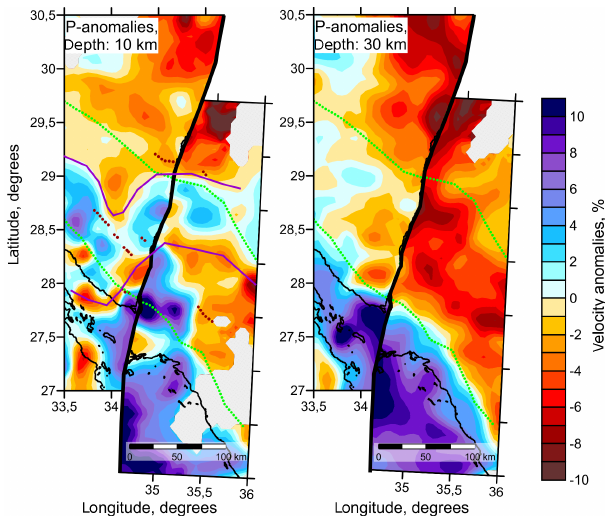
Figure 11. Back-reconstruction of the P velocity model at 10 and 30km depth according to the DST displacements presented in Fig. 10. Green dotted lines depict the reference markers for the dis- placement. Violet lines are the structures discussed in the text. The red dotted lines are dykes according to Eyal et al.